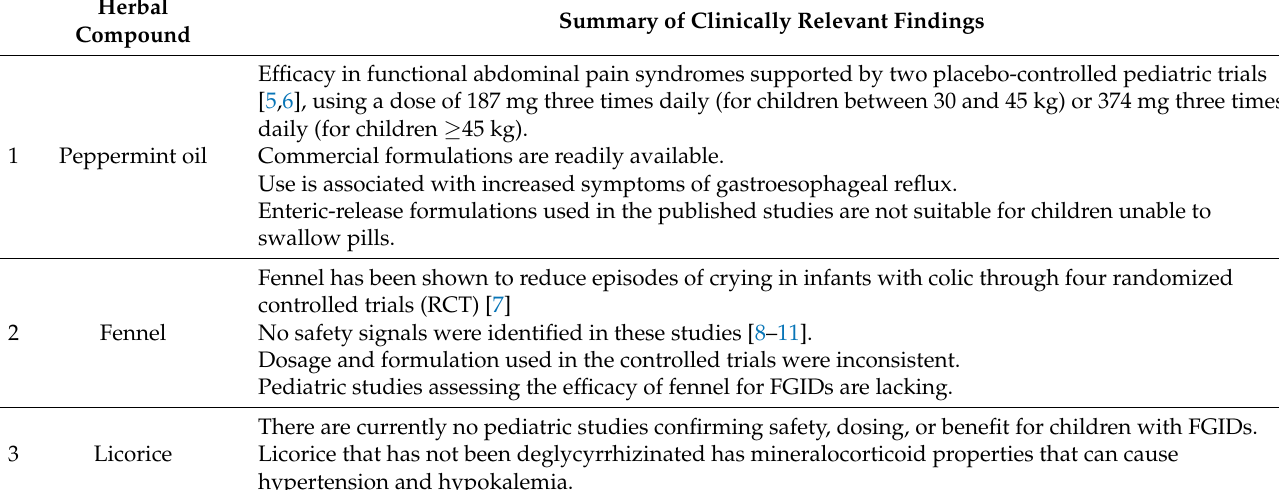
Table 1. Summary of clinically relevant